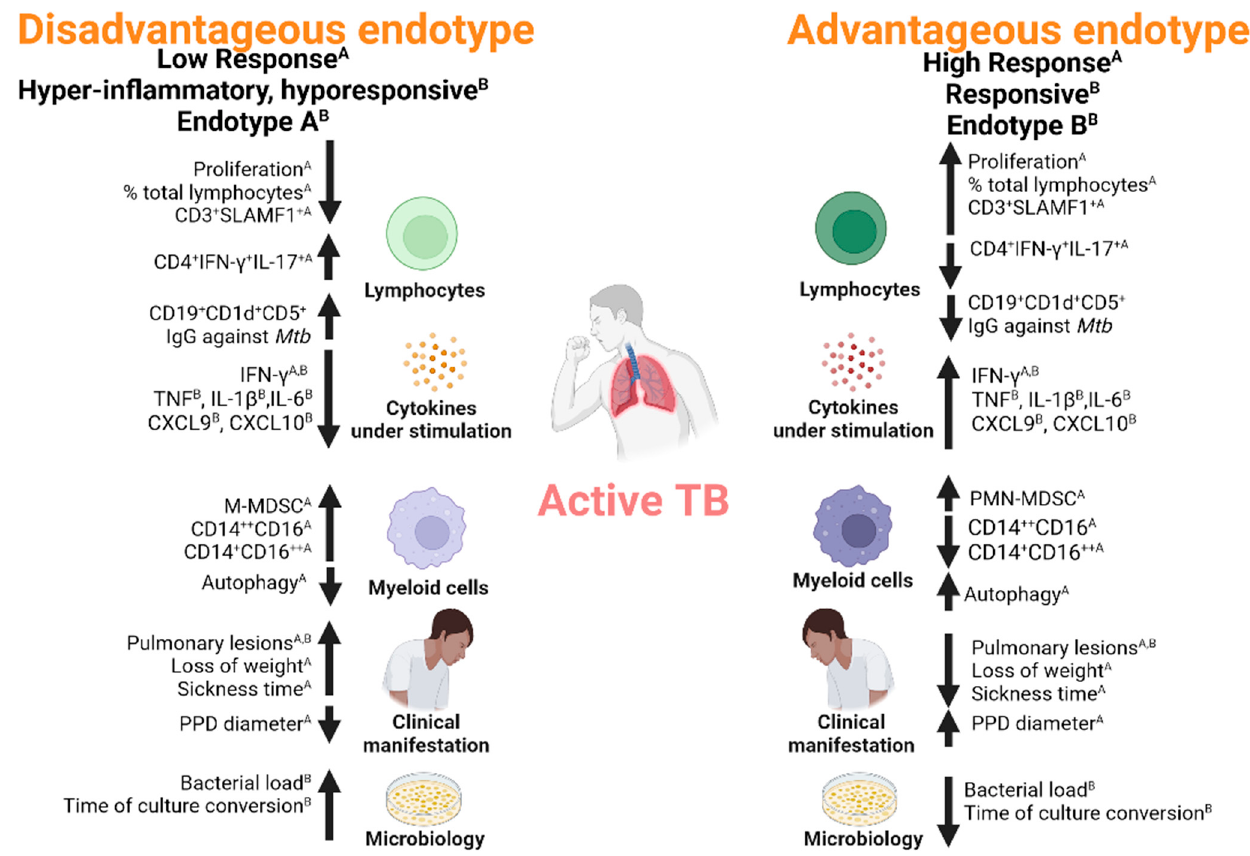
Figure 1. Characterization of immune endotypes in patients with active TB. The figure shows schematic categorization examples of immune endotypes in TB. The Disadvantageous and Advantageous endotypes are displayed as: (i) Low Responder/High Responder types defined according to the criteria indicated as (A) [26]; (ii) Hyporesponsive/Hyper-inflammatory, hyporesponsive; and (iii) Endotype A/Endotype B defined according to the criteria indicated as (B) [13]. The Disadvantageous endotype includes TB patients with weak or no T-cell responses to Mtb -Ag, more severe disease [7,26], high levels of CD19 + CD1d + CD5 + regulatory B-cells [29] and decreased levels of cytokines released [7,13,26]. Moreover, M-MDSC and intermediate and non-classical monocyte populations are augmented in the Disadvantageous endotype [27]. Furthermore, autophagy is diminished in this endotype [30,31]. The Advantageous endotype corresponds to TB patients that display strong T cell immunity to Mtb -Ag, milder manifestations of the disease [7,26] and increased levels of cytokines released [7,13,26]. Additionally, the PMN-MDSC are augmented in the Advantageous endotype, the intermediate and non-classical monocyte populations are diminished [27] and robust autophagic responses are observed [30,31]. Figure created with BioRender.com.